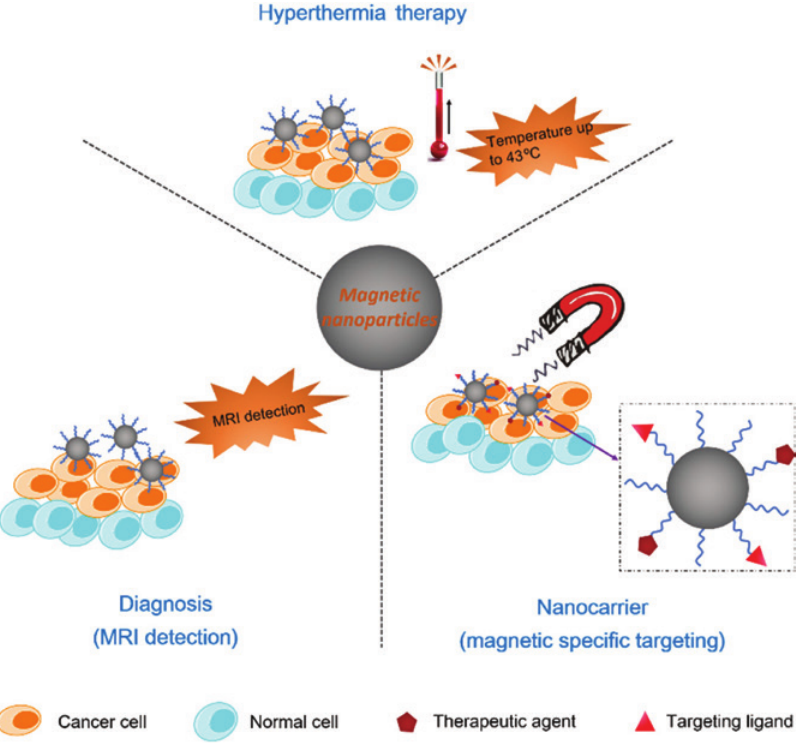
Figure 5: Example of magnetic nanoparticle for cancer therapy. Nanocarrier, diagnosis and hyperthermia